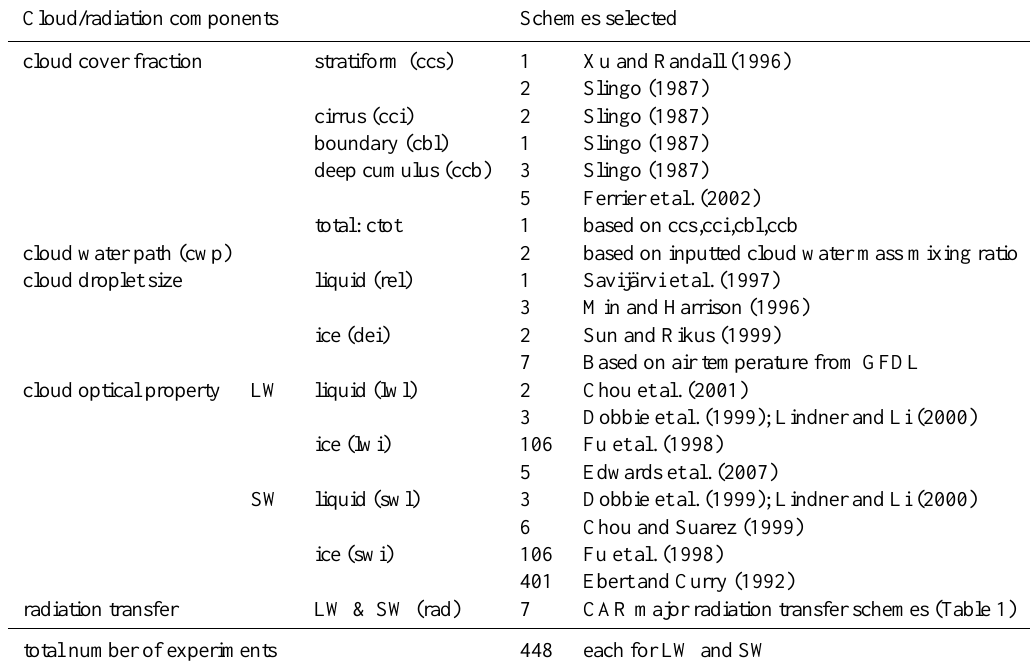
Table 2. The experiment design for CAR cloud radiative forcing